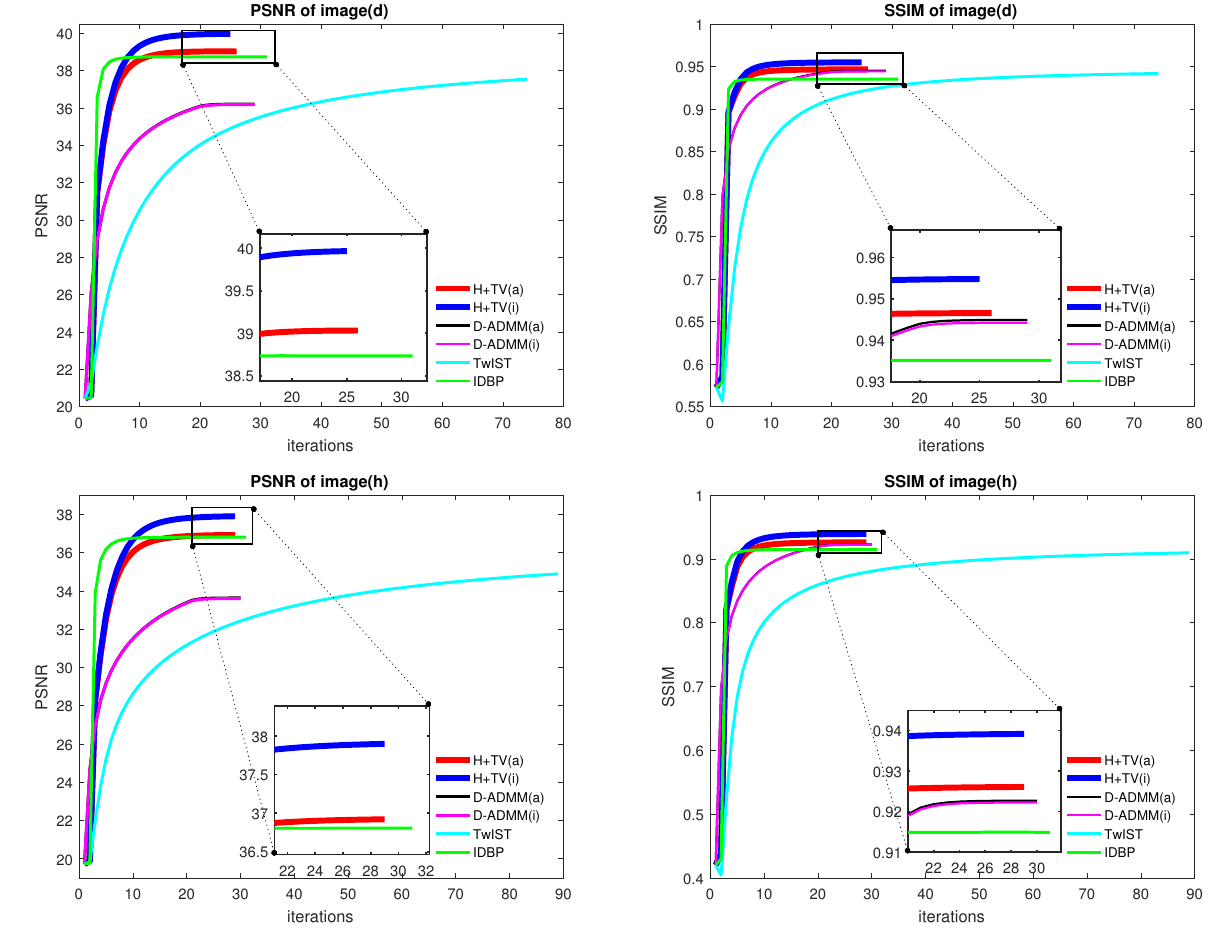
Figure 4. Iteration-varying of PSNR and